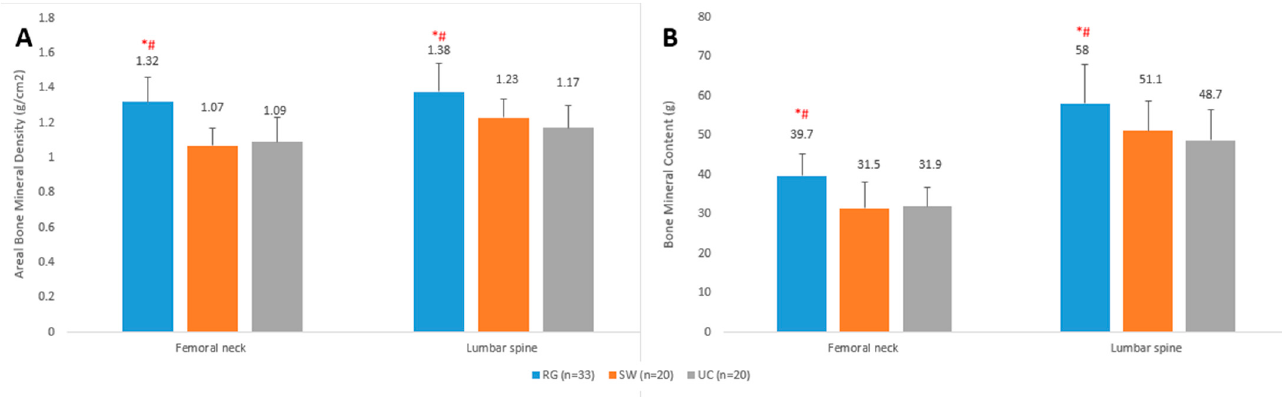
Figure 1. Mean (±SD) areal bone mineral density ( A ) and bone mineral content ( B ) values of rhythmic gymnasts (RG), swimmers (SW) and untrained controls (UC). * Significantly different from untrained controls; p < 0.05. # Significantly different from swimmers; p < 0.05. Table 2. Pearson correlation coefficients of bone mineral values with blood biochemical, training and body compositional variables.